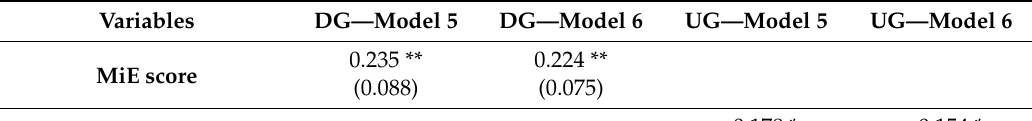
Table A1. Additional models: Big Five and REI-40 in DG and